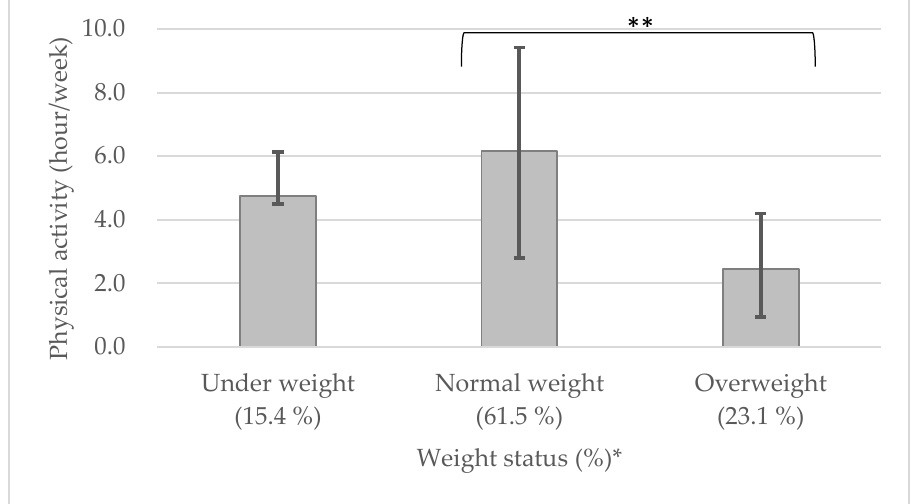
Figure 1. Association between physical activity and body weight of observed students. * Based on body mass index (BMI; in kg/m2). Under 18.5: underweight, over 18.5 and under 25.0: normal weight and over 25.0: overweight. ** p < 0.05: weight status vs. the weekly hours of physical activity. Significant differences correspond to Student’s t -test with each category of weight status.